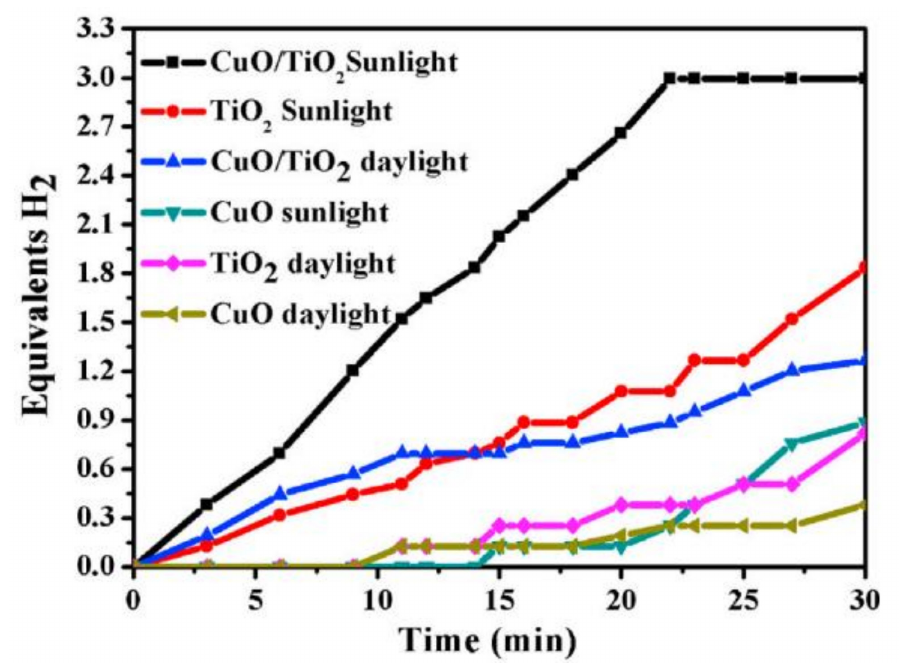
Figure 17. Catalytic performance of TiO 2 NFs with and without the incorporation of CuO in daylight and sunlight for AB hydrolysis reaction. Reprinted from reference [16] with permission from